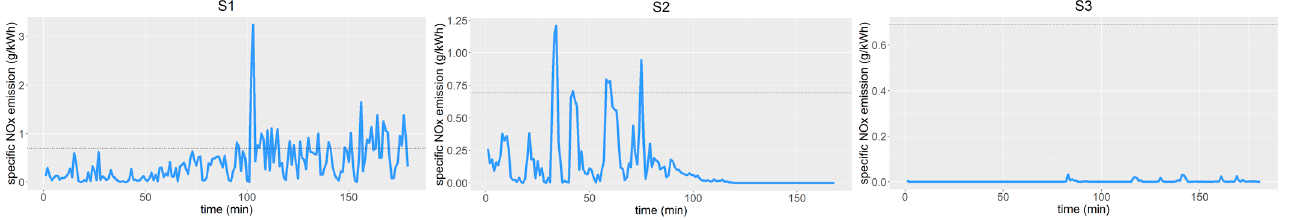
1 Table 6. Model evaluation.